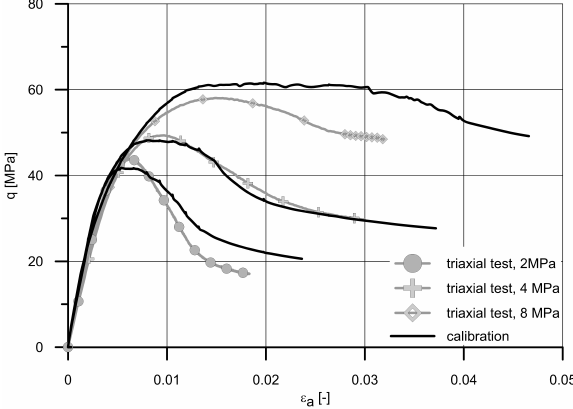
Figure 6. Measured and predicted stress-strain curves with strain softening in after failure part from CS-2 profile.